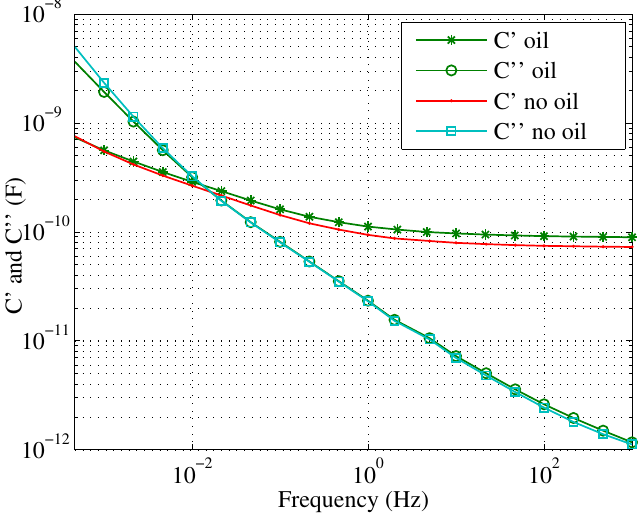
Figure 8. Capacitance and dielectric losses measured with the probe immersed in oil and surrounded by air. Measurements were done for a sample with a moisture content